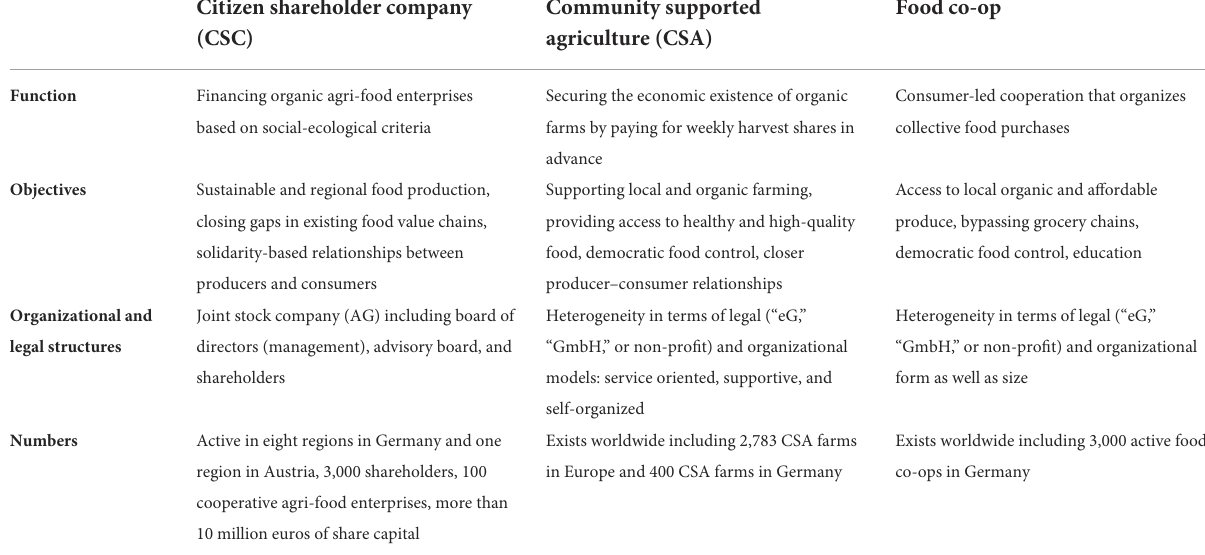
TABLE 2 Main characteristics of selected social food